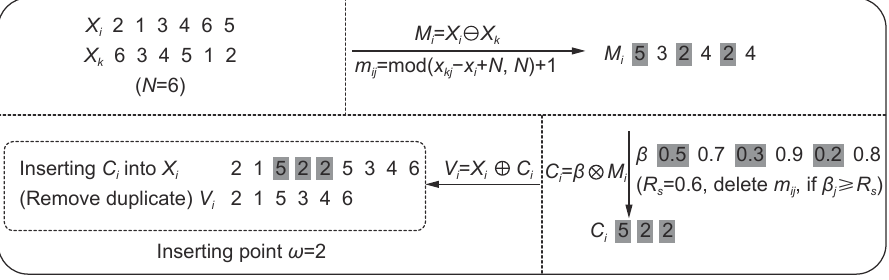
for a solution X i i